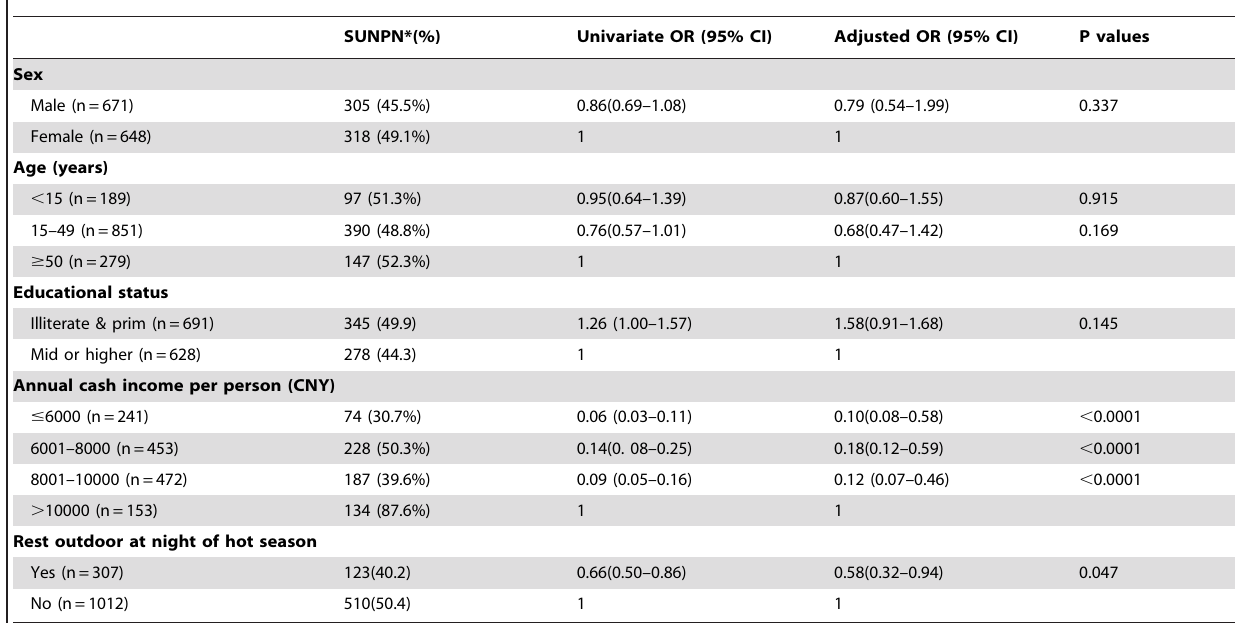
Table 2. Personal Variables related to use of bed nets in Jinuo people, Yunnan,